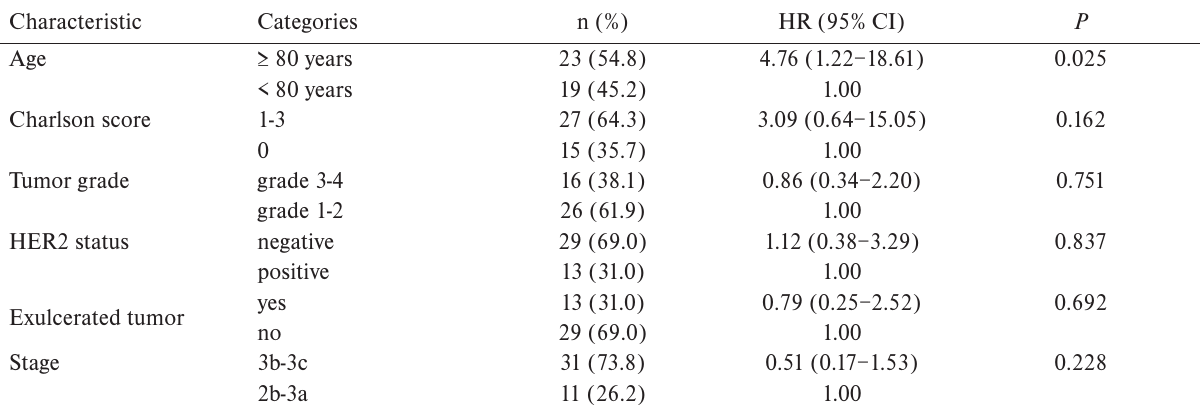
Table 4. Multivariable Cox analysis of baseline characteristics predictive for overall